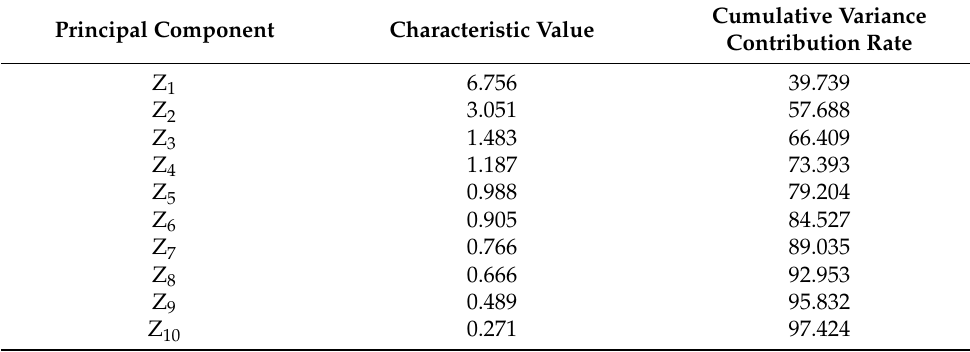
Table 7. Characteristic value and cumulative variance contribution